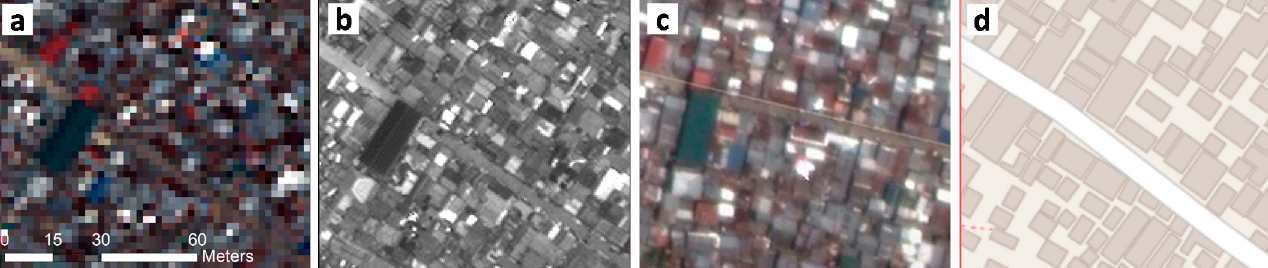
Figure 3. Examples of used data for training area selection. ( a ) Original satellite image used for slum detection, ( b ) panchromatic image, ( c ) Google Earth image, and ( d ) OpenStreetMap for before Haiyan time (i.e., 2013).